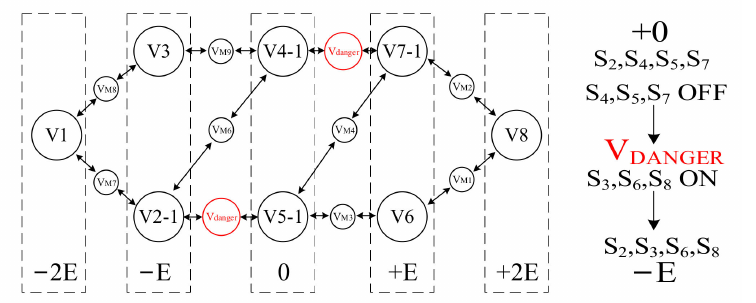
Figure 4. Traditional switching process of the ANPC-5L